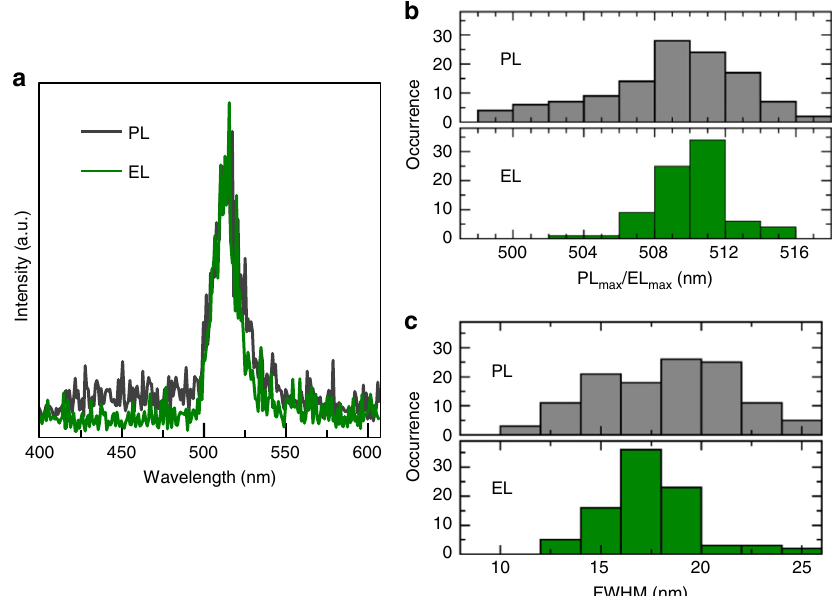
Fig. 2 Spectral characterization in PL and EL. a Example of PL (black, excited at 485 nm) and EL (green, at the bias of 14 V) spectra taken from the same NC aggregate in the EL device. b Distribution of PL (top) and EL (bottom) spectral peak positions. c Distribution of PL (top) and EL (bottom) spectral linewidths (FWHM). The distributions in b and c were constructed from 80 NC aggregates in EL at the bias of 14 V and from 118 NC aggregates in PL excited at 485